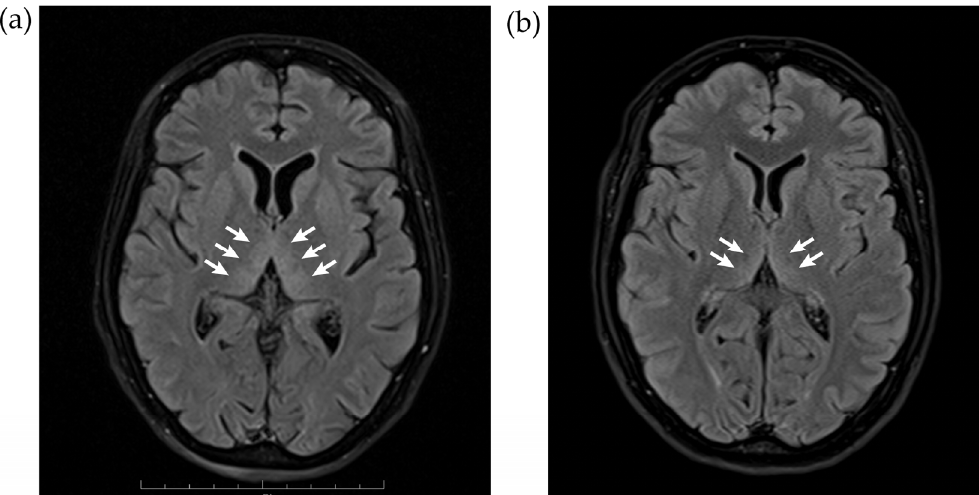
Figure 1. Axial 1.5 Tesla T2 fluid-attenuated inversion recovery (FLAIR) weighted MRI scans showing the bilateral thalamic hyperintensities (arrows) during the stage with acute Wernicke encephalopathy signs, four days after hospital admission (echo time [TE] = 78 ms; repetition time [TR] = 5070 ms) ( a ), which were significantly reduced at the time of the neuropsychological assessment five months later (TE = 84 ms; TR = 9000 ms) ( b